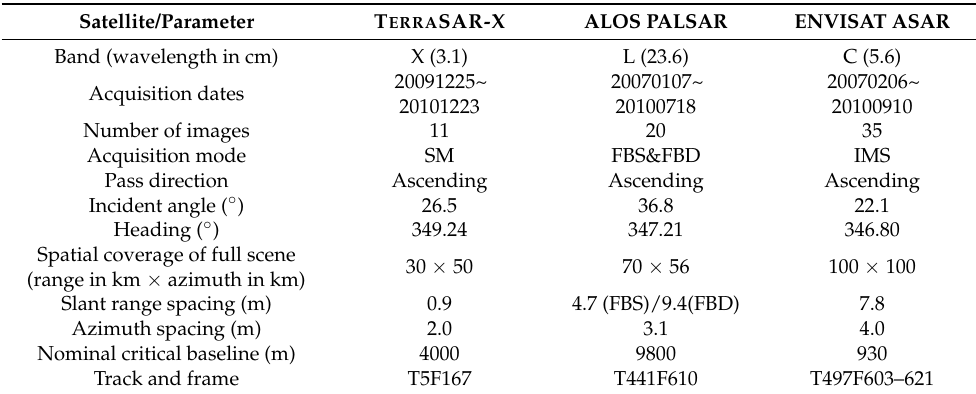
Figure 3. ( a ) The coverage of TerraSAR-X, ALOS PALSAR, and ENVISAT ASAR data; ( b ) The detailed map of LNC and the locations of leveling benchmarks. Black triangles indicate the locations of benchmarks. The background figure is a Landsat TM/ETM+ image acquired on 1 November 2010. Table 1. Basic parameters of the three SAR data